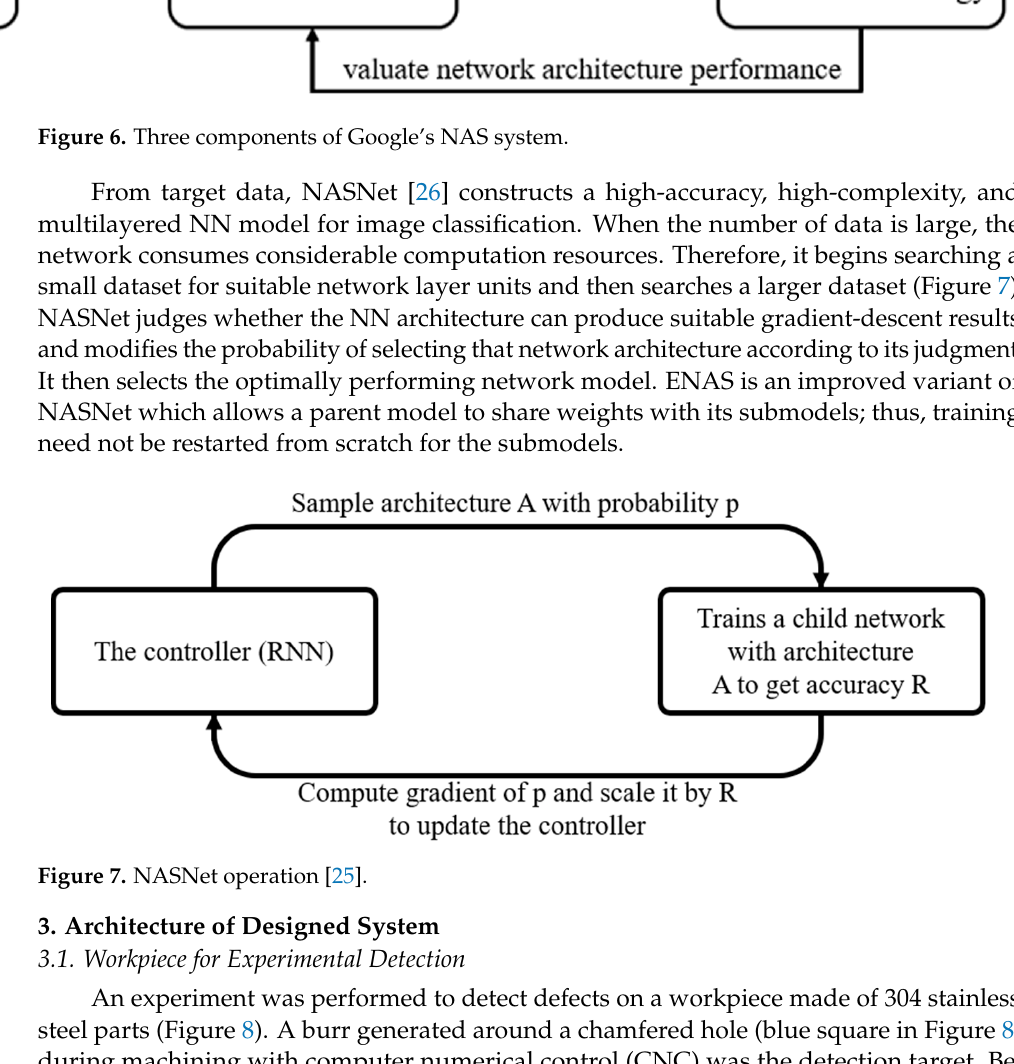
Figure 7. NASNet operation [25].